Question: Author a descriptive caption for the visualization shown.
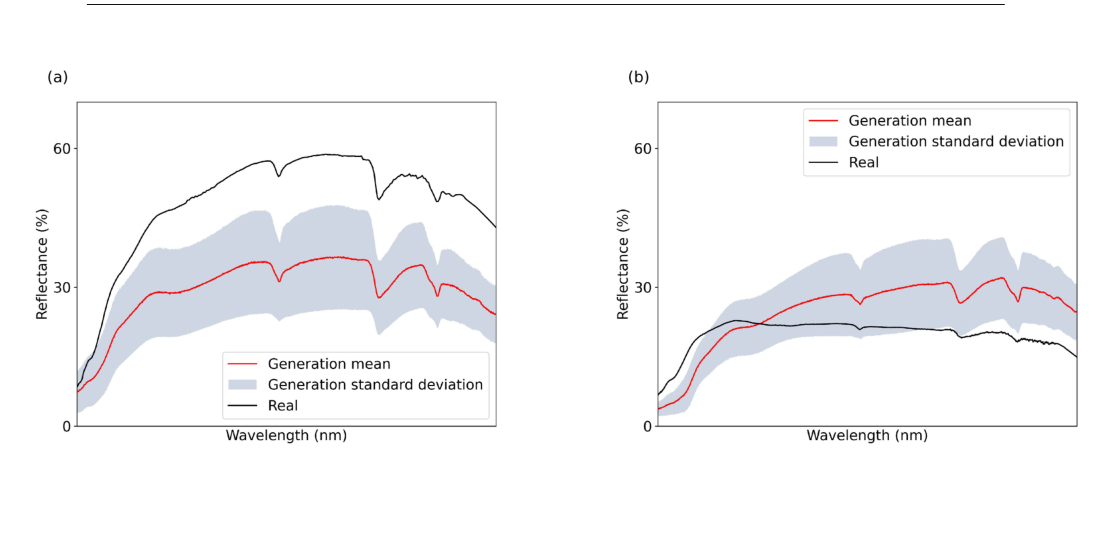
Answer: Example real soil reflectance spectra and mean and standard deviation of generated soil reflectance spectra with similar soil particle fraction properties and spectrometer manufacturer (ASD). (a) Clay : 22.0%; Silt : 26.0%; Sand : 52.0%. (b) Clay : 17.3%; Silt : 26.1%; Sand : 56.6%.